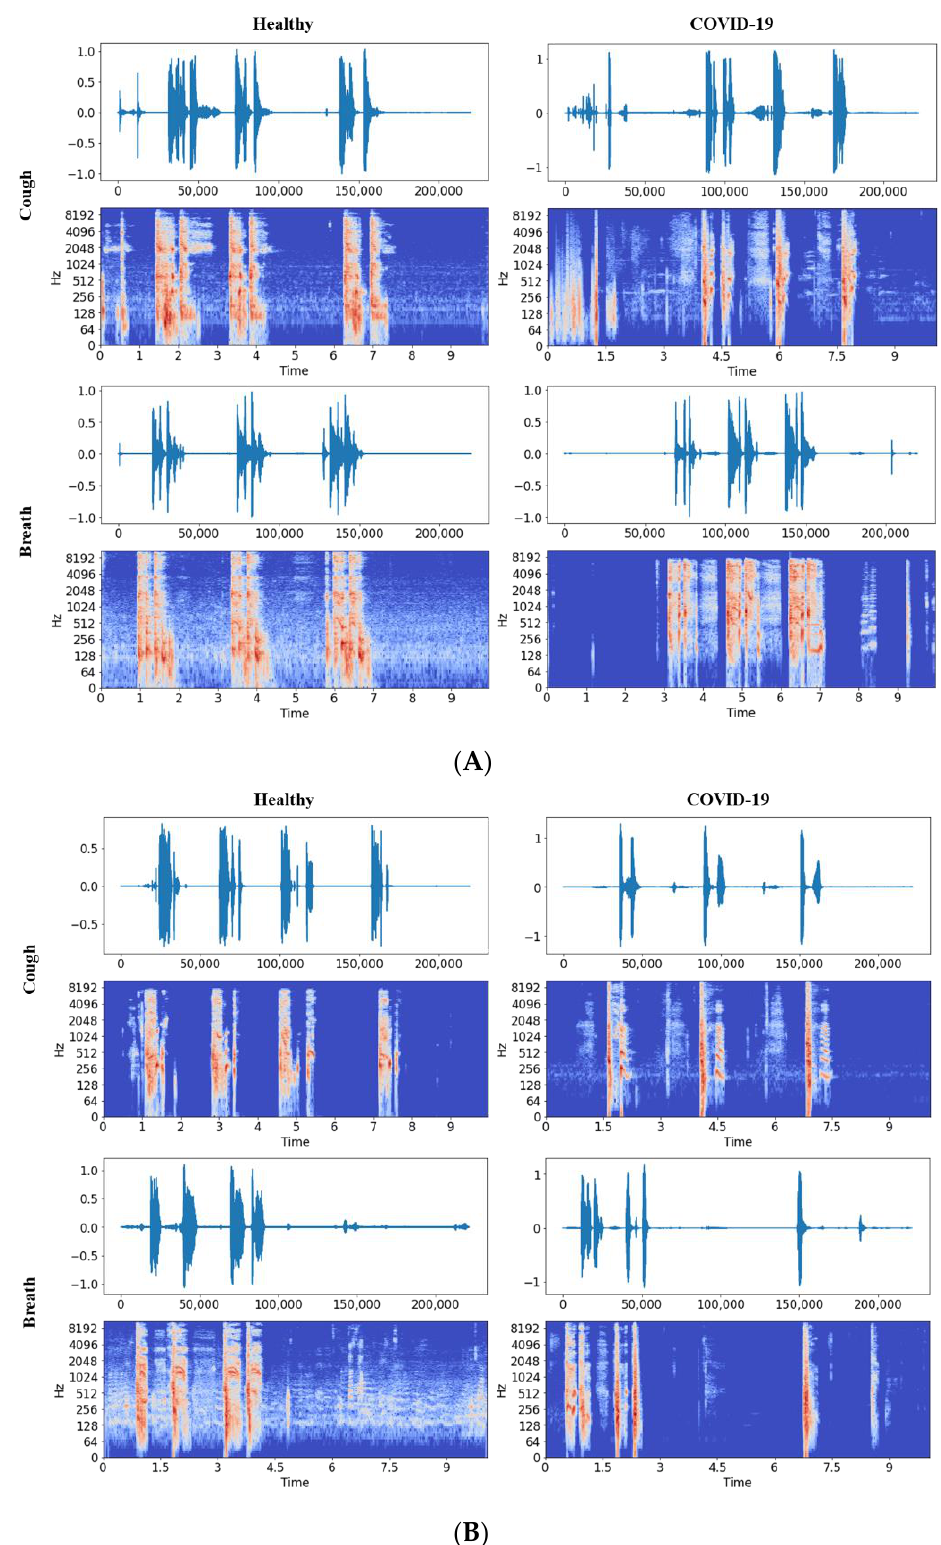
Figure 2. Cough and breath sound waveforms and spectrograms for ( A ) symptomatic and ( B ) asymptomatic healthy subjects and COVID-19 patients.